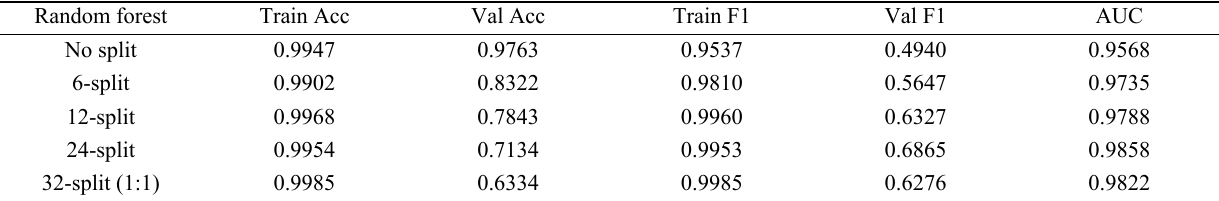
Table 9 Algorithm performance of RF using different splitting strategies (337 control variables). Random